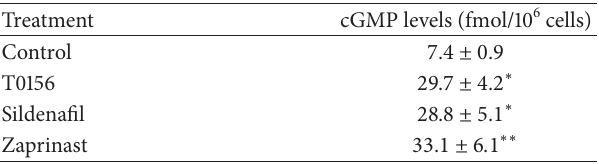
Table 1: PDE5 inhibitors increased the levels of cGMP in SVZ